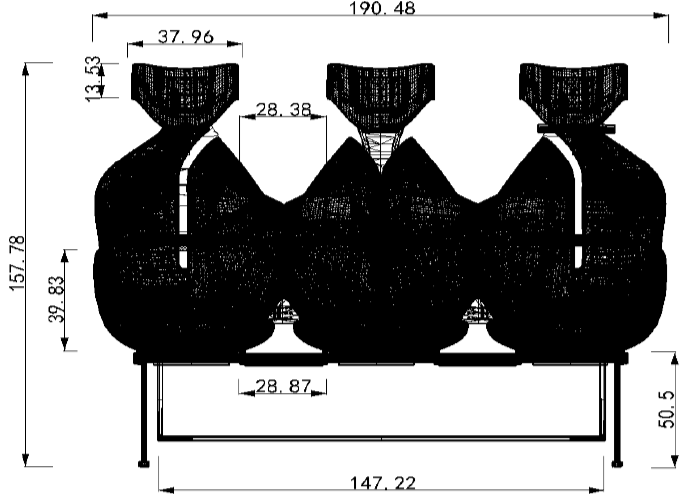
Figure 38. Front dimension.